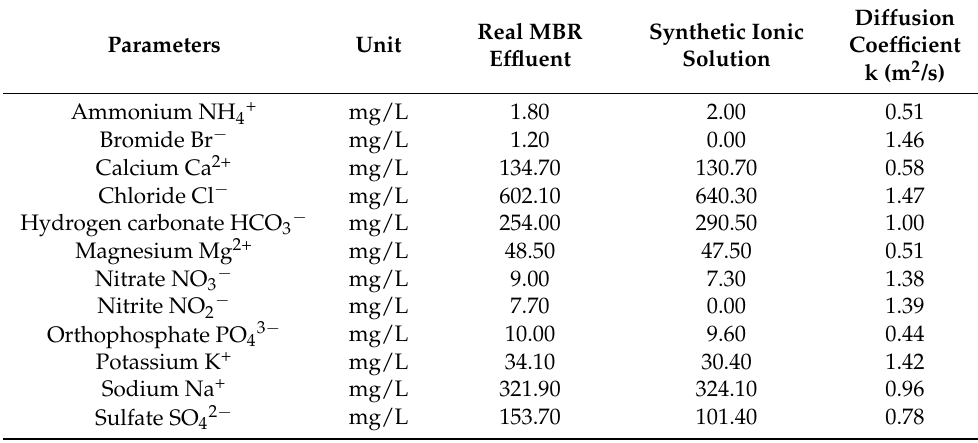
Table 2. Ionic composition of real MBR effluent and synthetic ionic